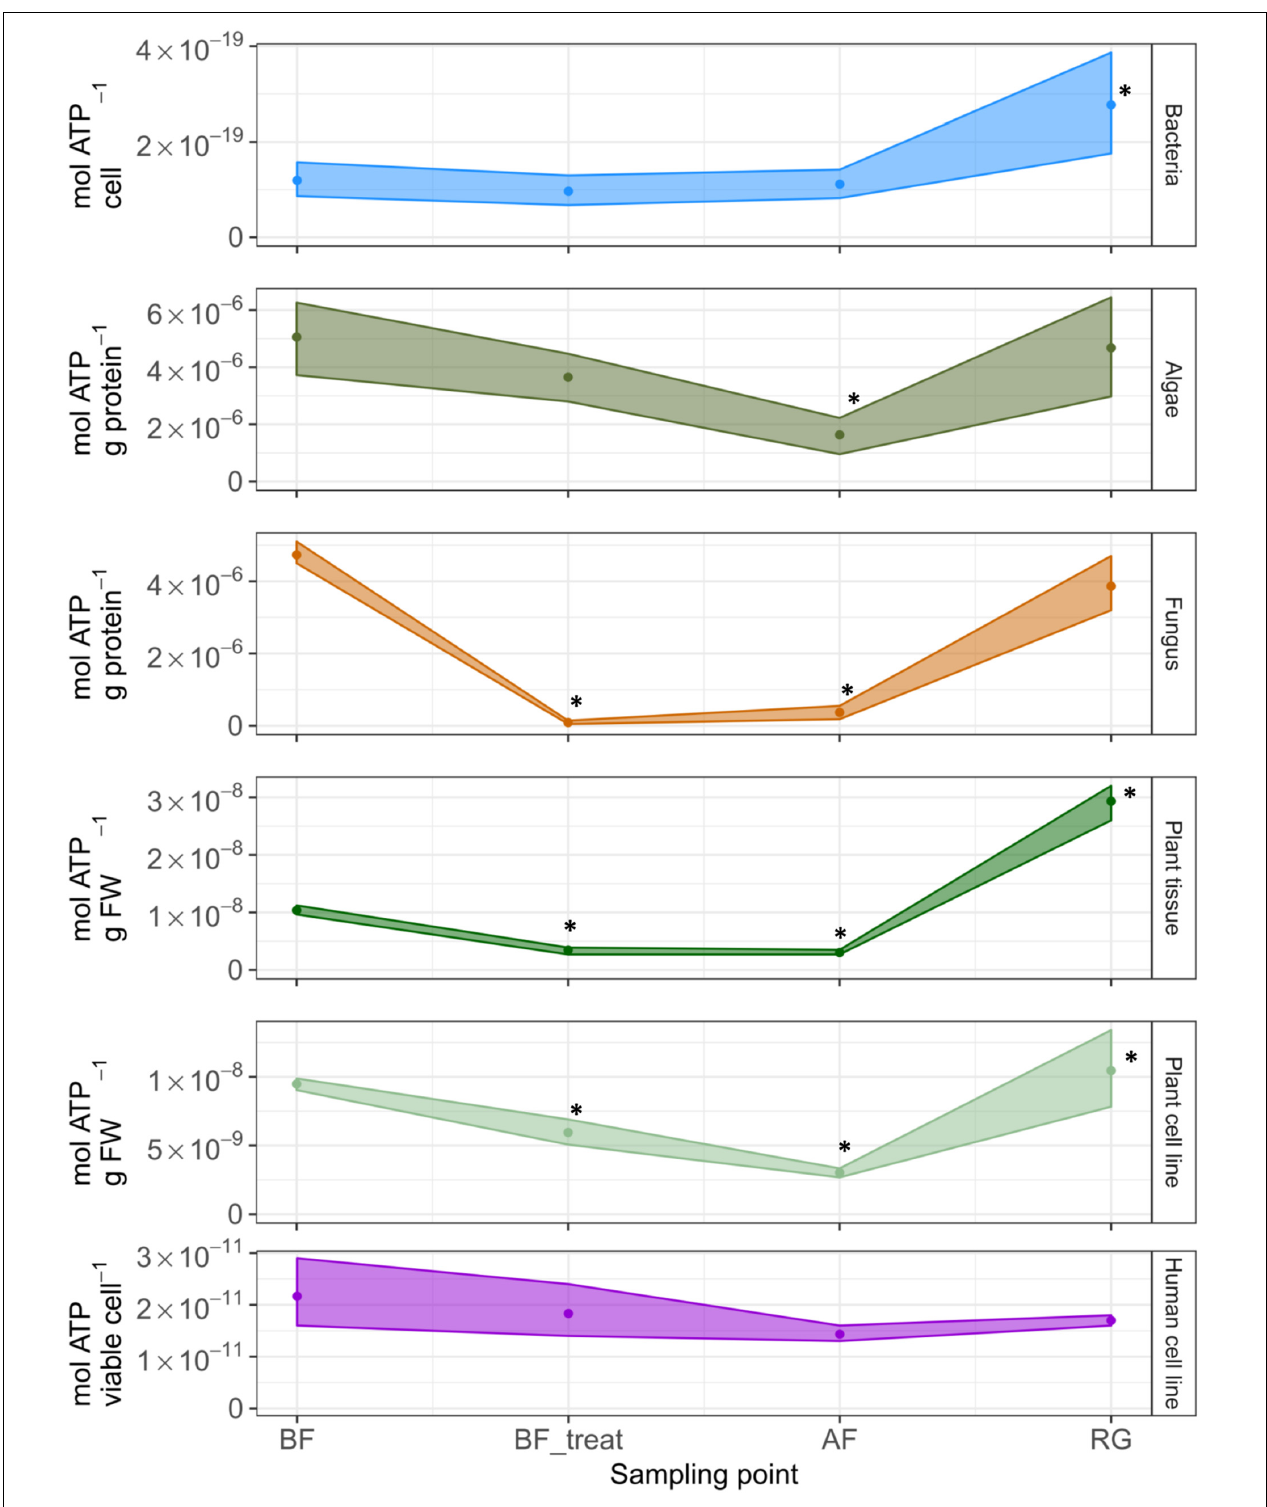
FIGURE 1 | Changes in intracellular ATP levels observed for the different model organisms during cryostress experiments. Points denote the mean ATP content of all representatives of a group of organisms at the individual sampling points. 95% confidence intervals are displayed as ribbons. Values that were significantly different ( p < 0.05) from the BF value within a group of organisms are marked with ∗ . FW, fresh weight; BF, before freezing; BF_treat, after treatment with cryoprotectant; AF, after freezing; RG, after the regrowth phase. Compare Supplementary Figure S1 for details on individual sampling points.